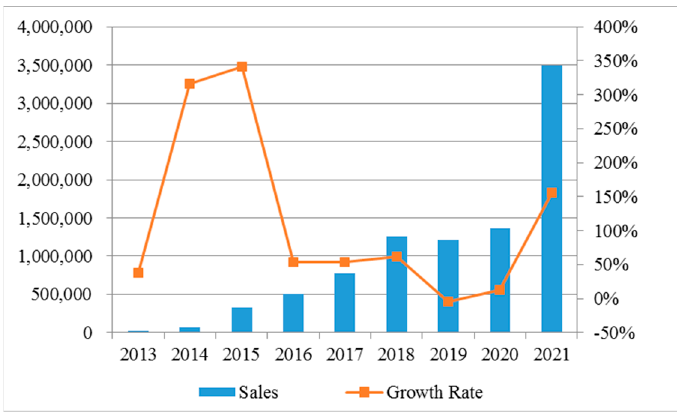
Figure 1. China’s new energy vehicle sales trend.